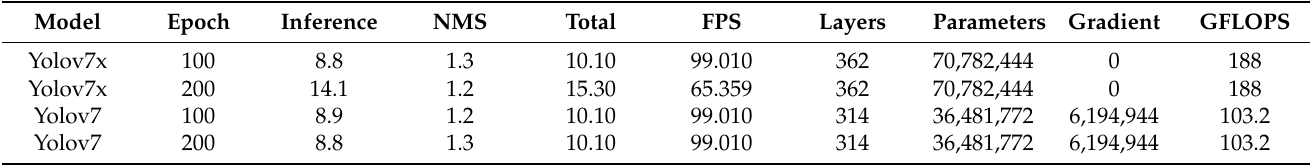
Table 3. An overview of Yolov7 models with Oxford Hand Dataset.